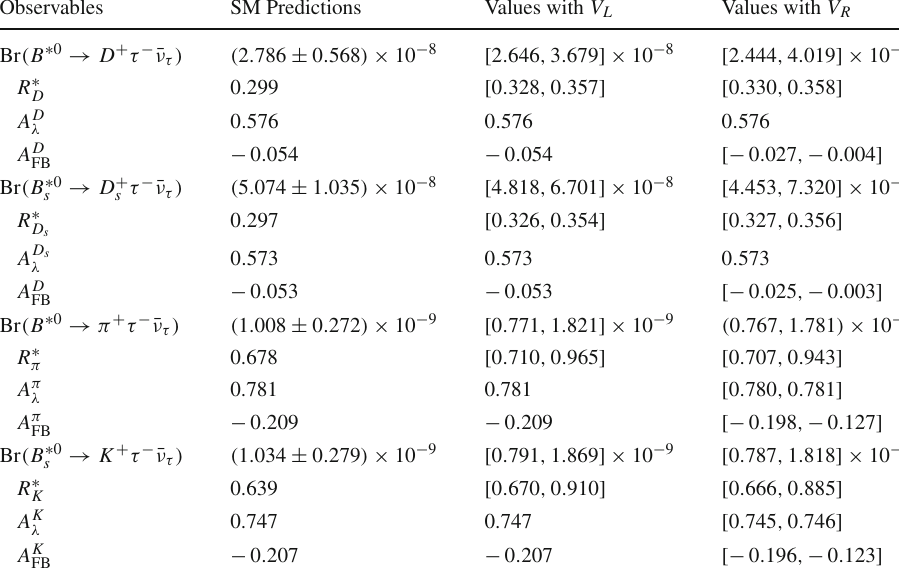
values of differential decay rate, LNU observables, lepton spin asymmetry and forward–backward